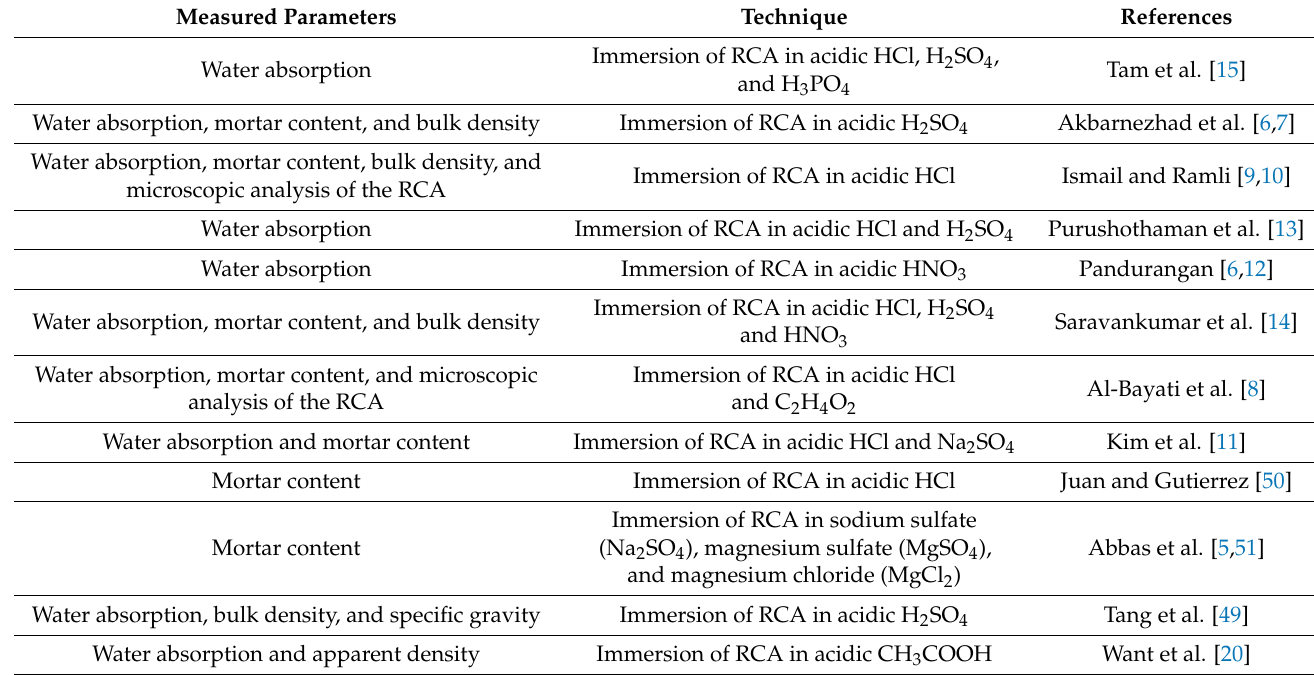
Table 1. Summary of physical and mechanical properties measured in concrete and mortar mixes, and techniques reported for